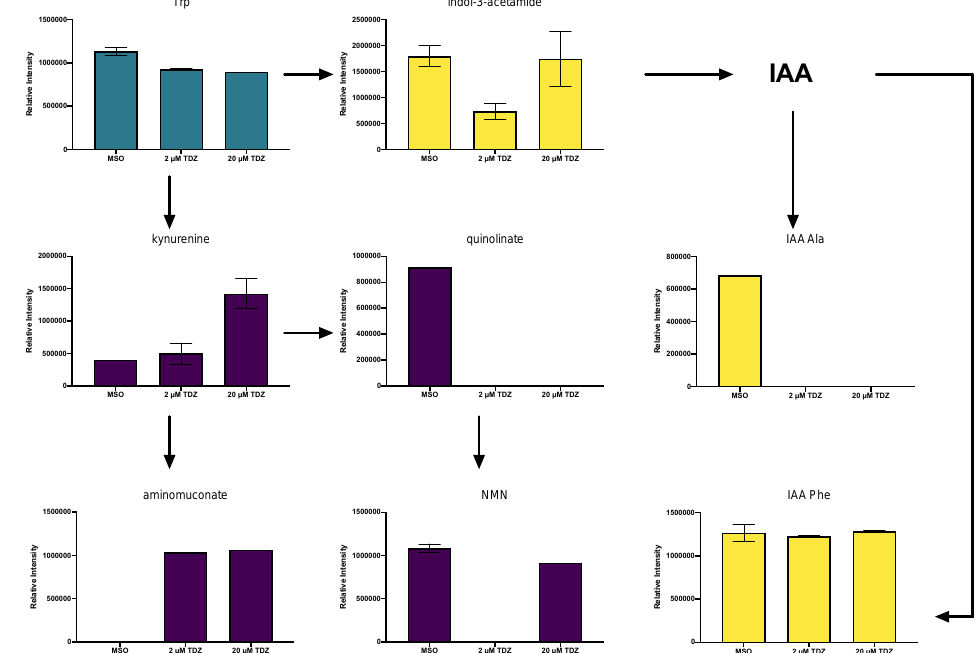
Figure 5. Effects of thidiazuron (TDZ) exposure on tryptophan (Trp) and auxin (inole-3-acetic acid; IAA) metabolism in African violet petioles. NMN, nicotinic acid mononucleotide. Bars represent mean, error bars span standard error margin. Where no error bars are displayed, the feature was present in only one replicate. Arrows indicate the normal flow of the pathways. Yellow indicates the IAA biosynthetic pathway, purple Trp degradation pathways.